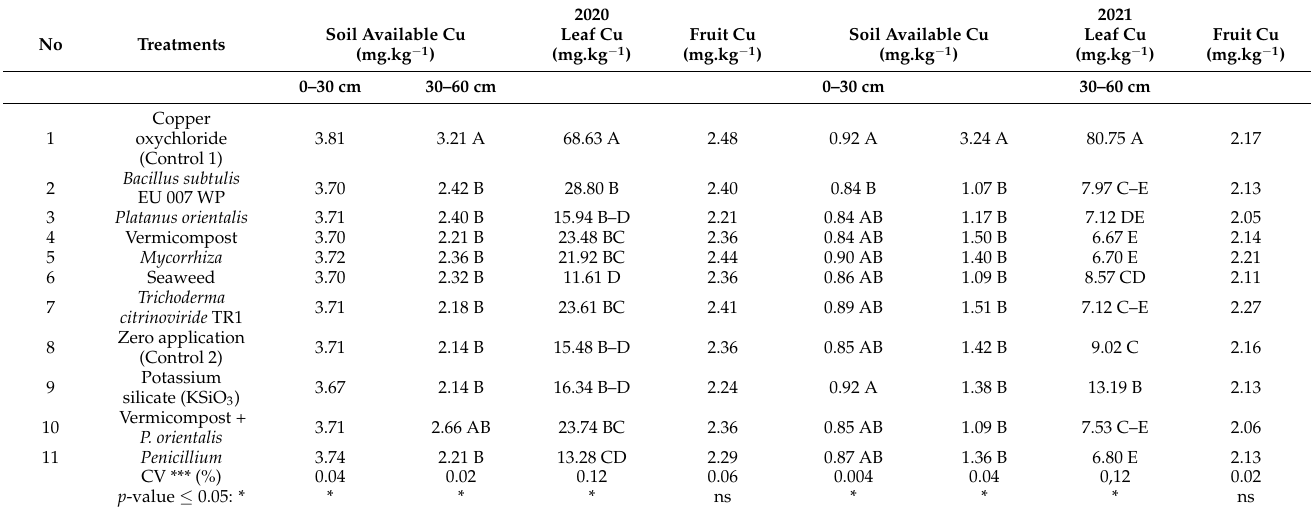
Table 4. Copper a content of soil, leaf and fruit sample results b in 2020 and 2021. Letters indicate significant